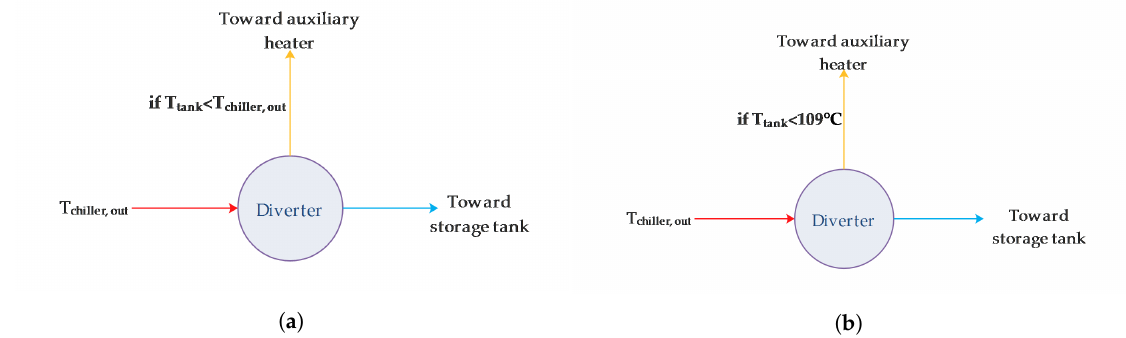
Figure 3. Mechanism of modified flow schemes. ( a ) Scheme 2. ( b ) Scheme